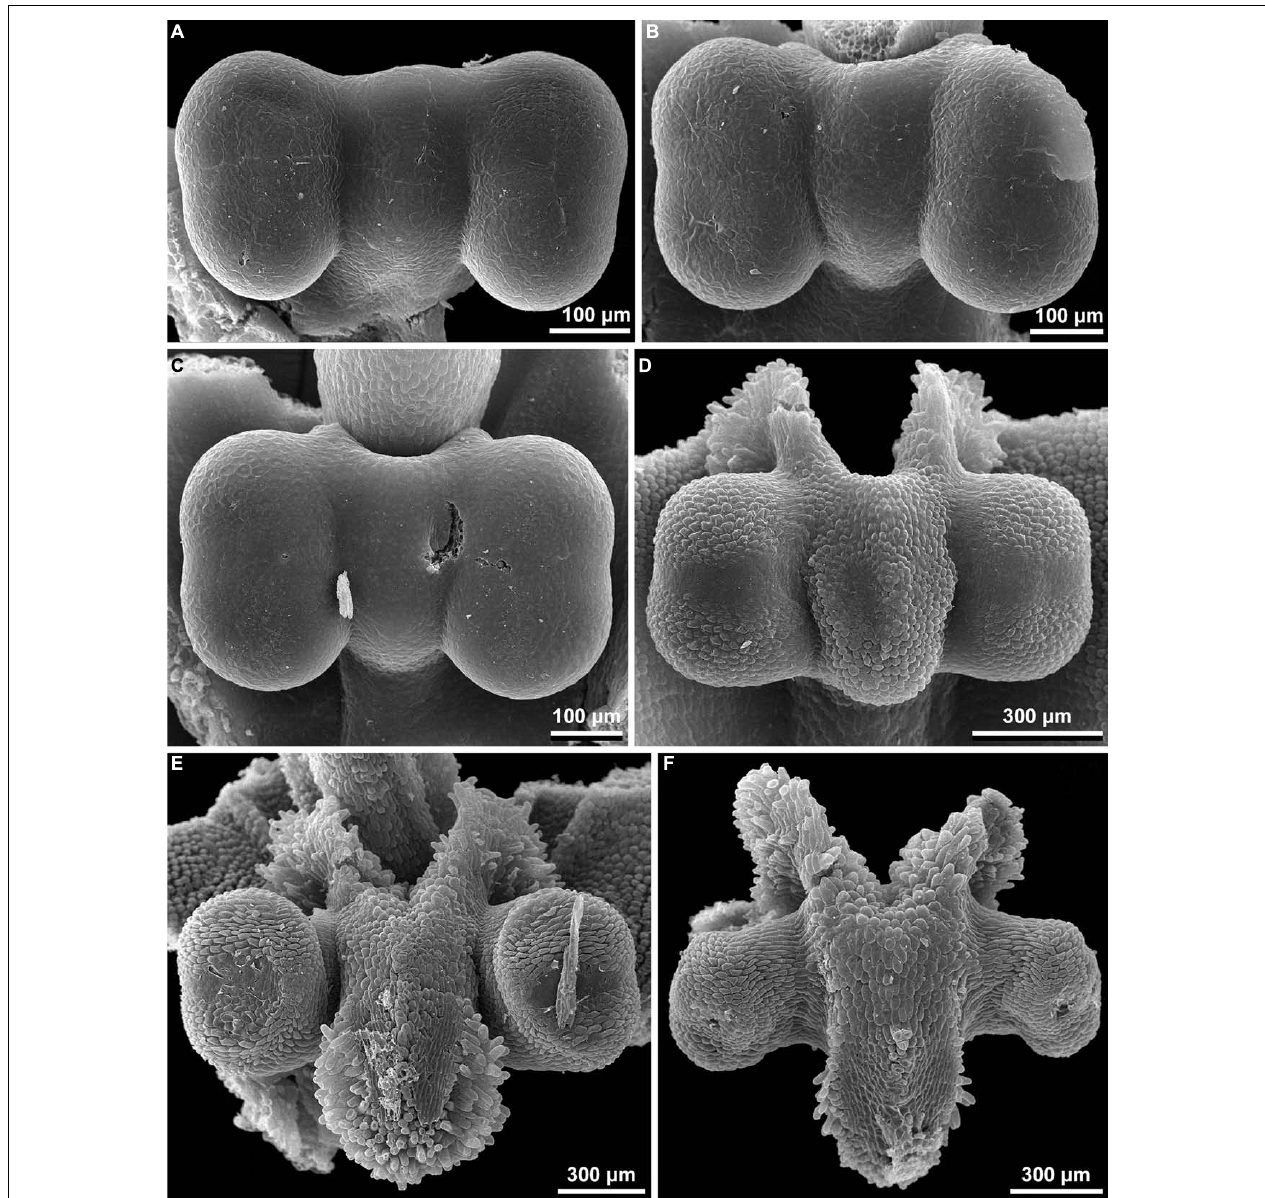
FIGURE 11 | (A–F) Stamen development of Burmannia disticha (SEM).